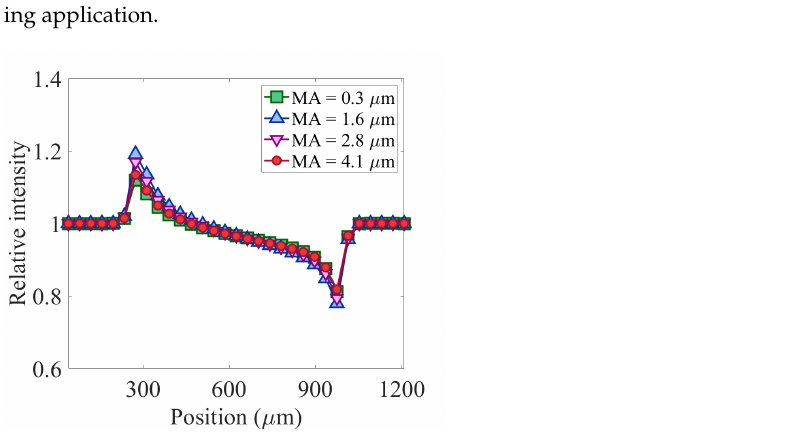
Figure 12. Illustration of simulation results of the effect of environmental vibration in the range of 2 µ m on the performance of an EI-XPCi system with pixel size equal to 39 µ m × 39 µ m.